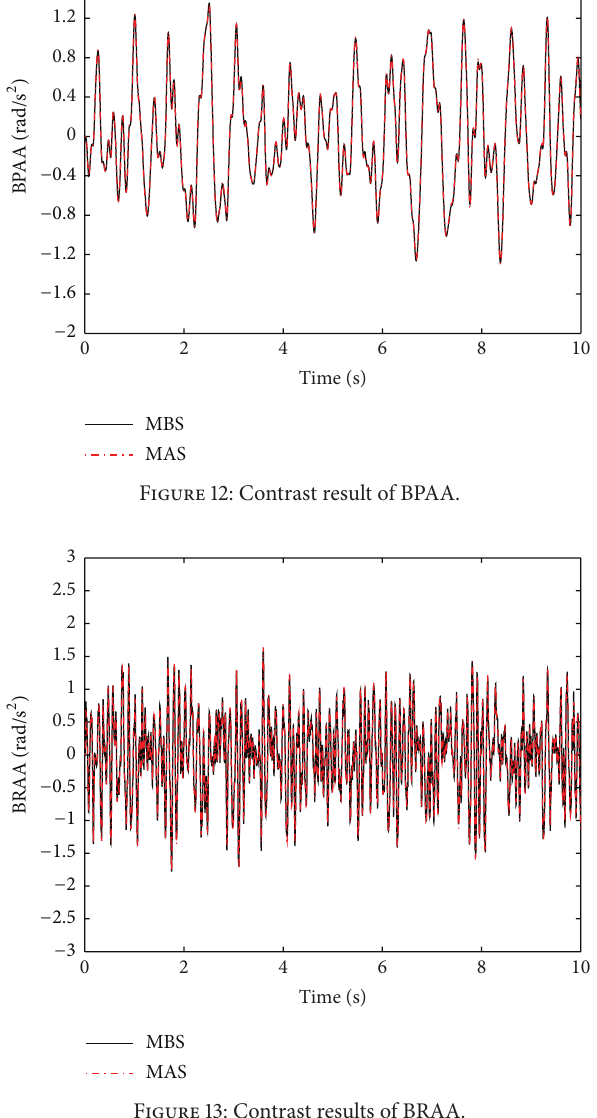
Figure 13: Contrast results of